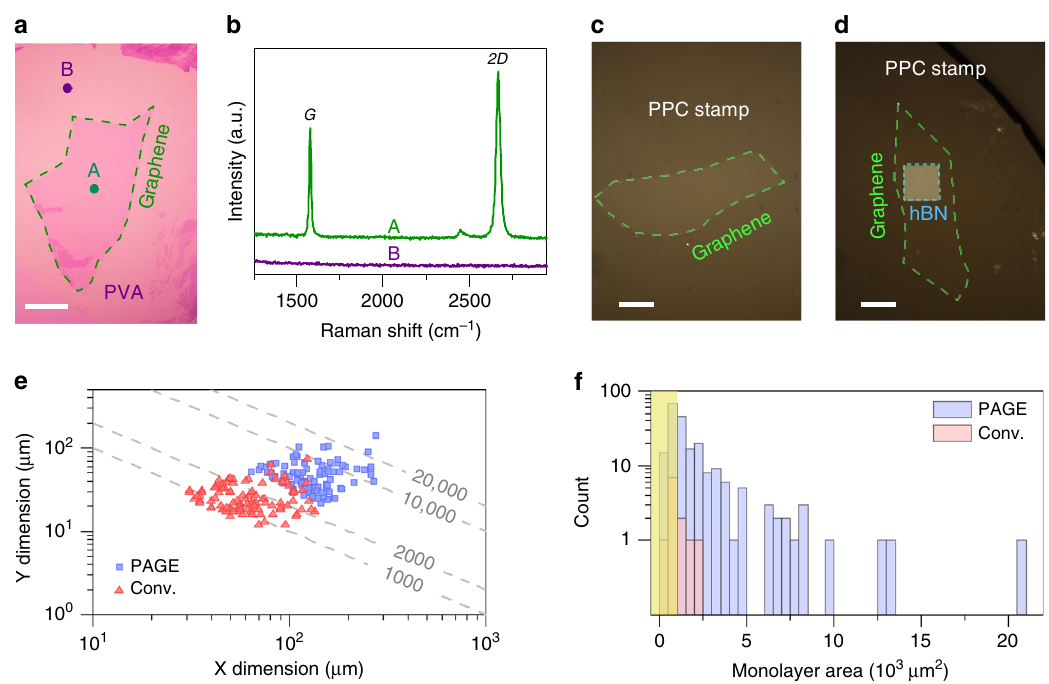
Fig. 2 PVA-assisted graphene exfoliation (PAGE). Our method allows the use of existing inspection techniques using a optical and b Raman microscopes for identifying monolayer fl akes. Scale bar in a is 50 μ m. The Raman spectra in the b correspond to the regions in the optical image of the a marked with “ A ” and “ B ” . We showed the effectiveness of our layer transfer method by picking up monolayer graphene using c a PPC stamp, and d an hBN/PPC stamp. Scale bars are 20 μ m. e PAGE reliably produced very large monolayer graphene fl akes, which were not attainable by the conventional method in our experiments. The dashed lines are guides to the eye and represent the product of X and Y dimensions equal to 1000, 2000, 10,000, and 20,000 μ m 2 . f The histogram plot showing the distribution of the monolayer fl ake area for the samples obtained from 15 consecutive exfoliation trials. The data indicate that PAGE is 20 times more likely than the conventional method (denoted as Conv.) to produce monolayer graphene with an area larger than 1000 μ m 2 (notice the distribution beyond the yellow shading). The yellow shading denotes fl akes with an area of <1000 μ m 2